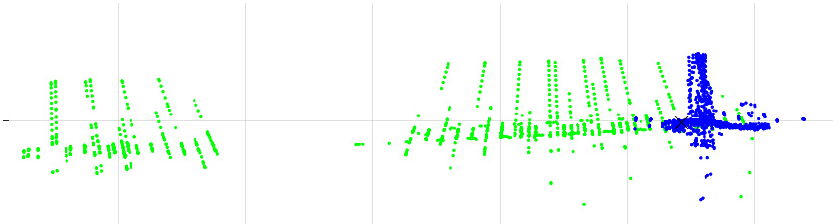
Figure 15. Reconstruction from sparse point clouds (total number of points is 4320) from data presented in Figure 14: the shape of the plane including the wings, tails are recognizable.